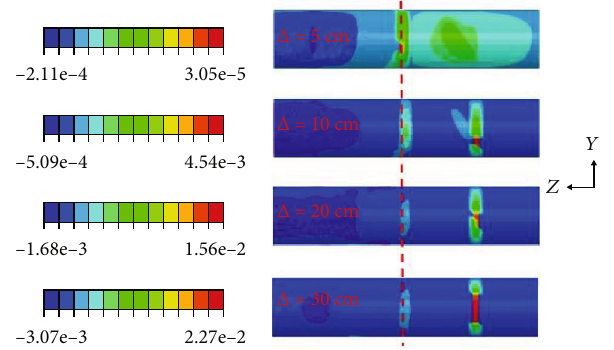
Figure 8: Axial strain of tunnel lining under fault